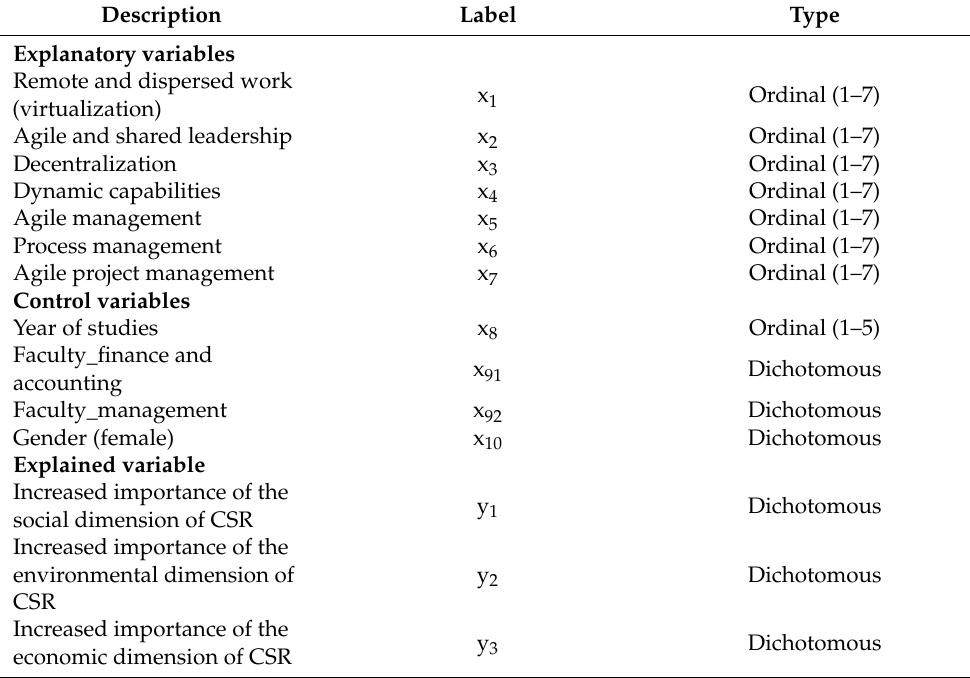
Table 2 presents the description and scale of all analyzed variables. Table 2. Description of